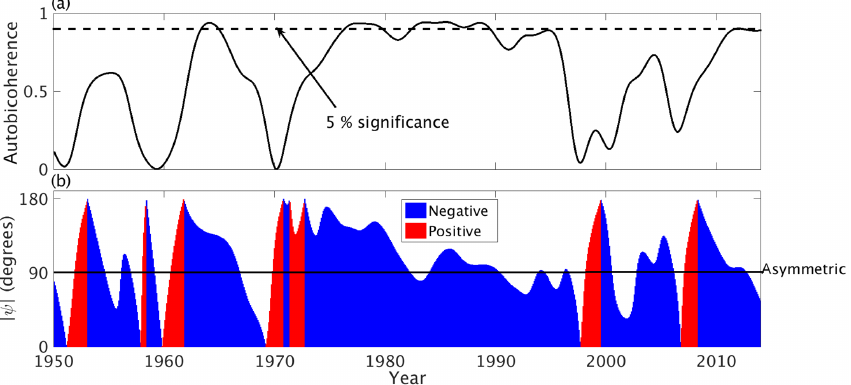
Figure 8. Same as Fig. 7 except at (28, 28) in the autobicoherence spectrum of the QBO index. Biphases differing from 90 ◦ indicate that the nonlinear interaction resulted in a waveform with